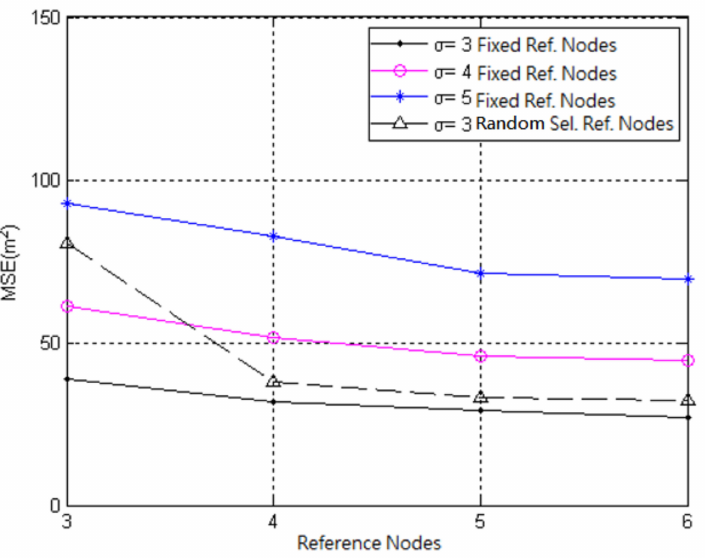
Figure 12. Comparison of the estimated small range of fixed reference nodes and random refer- ence